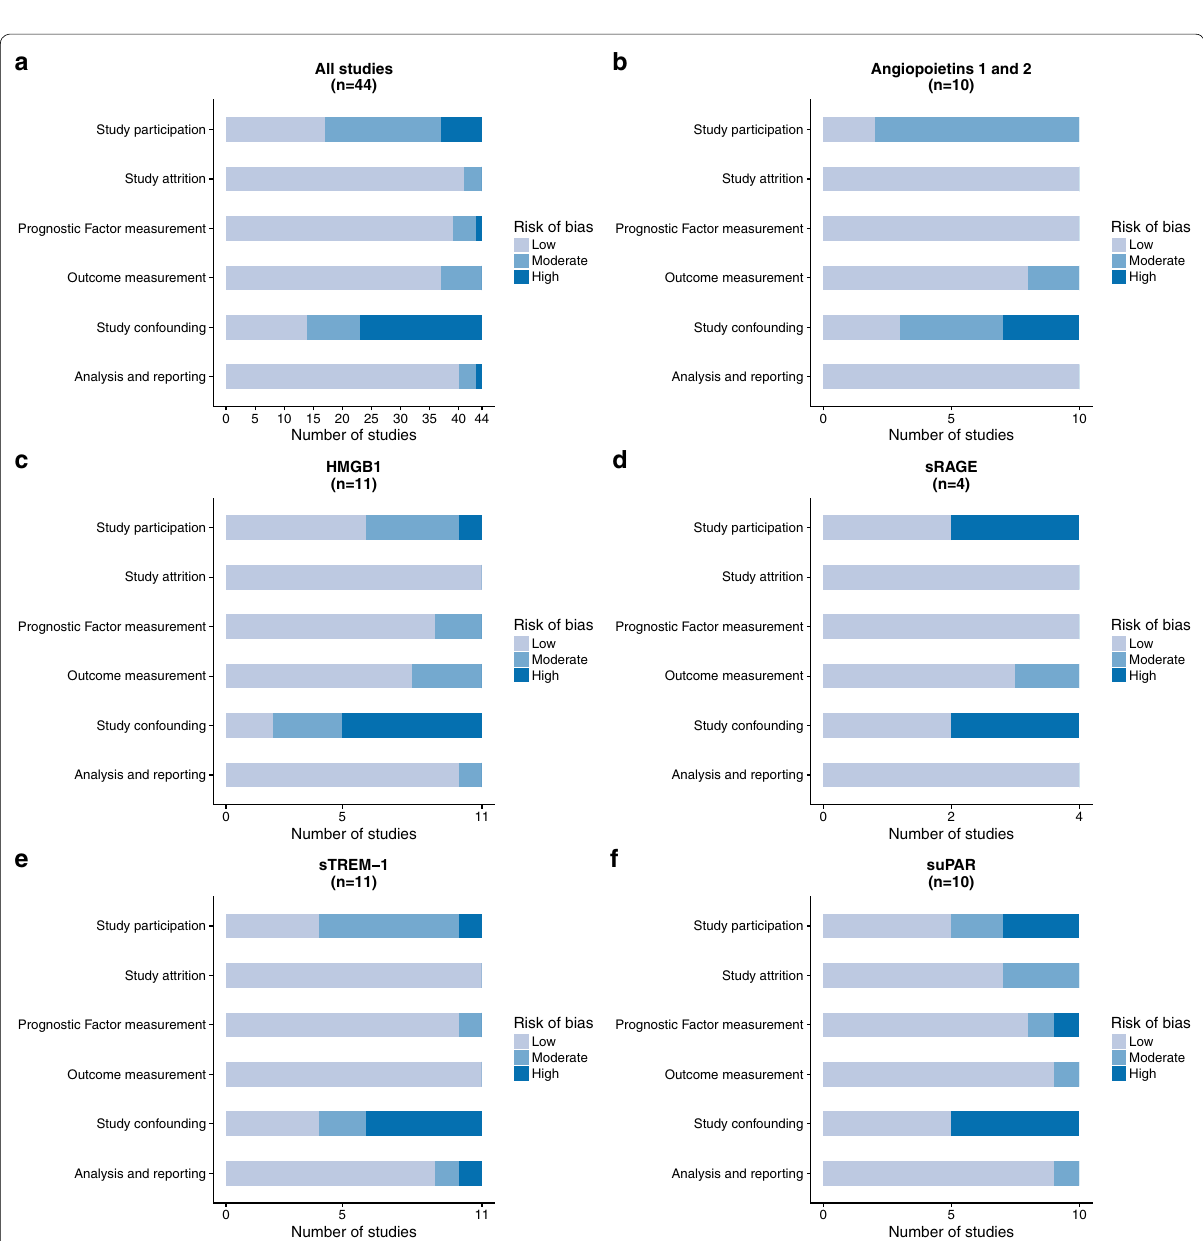
Fig. 3 Quality assessment of included studies, according to the six bias domains of the QUIPS tool. a Quality of all included studies, b – f quality of studies for each